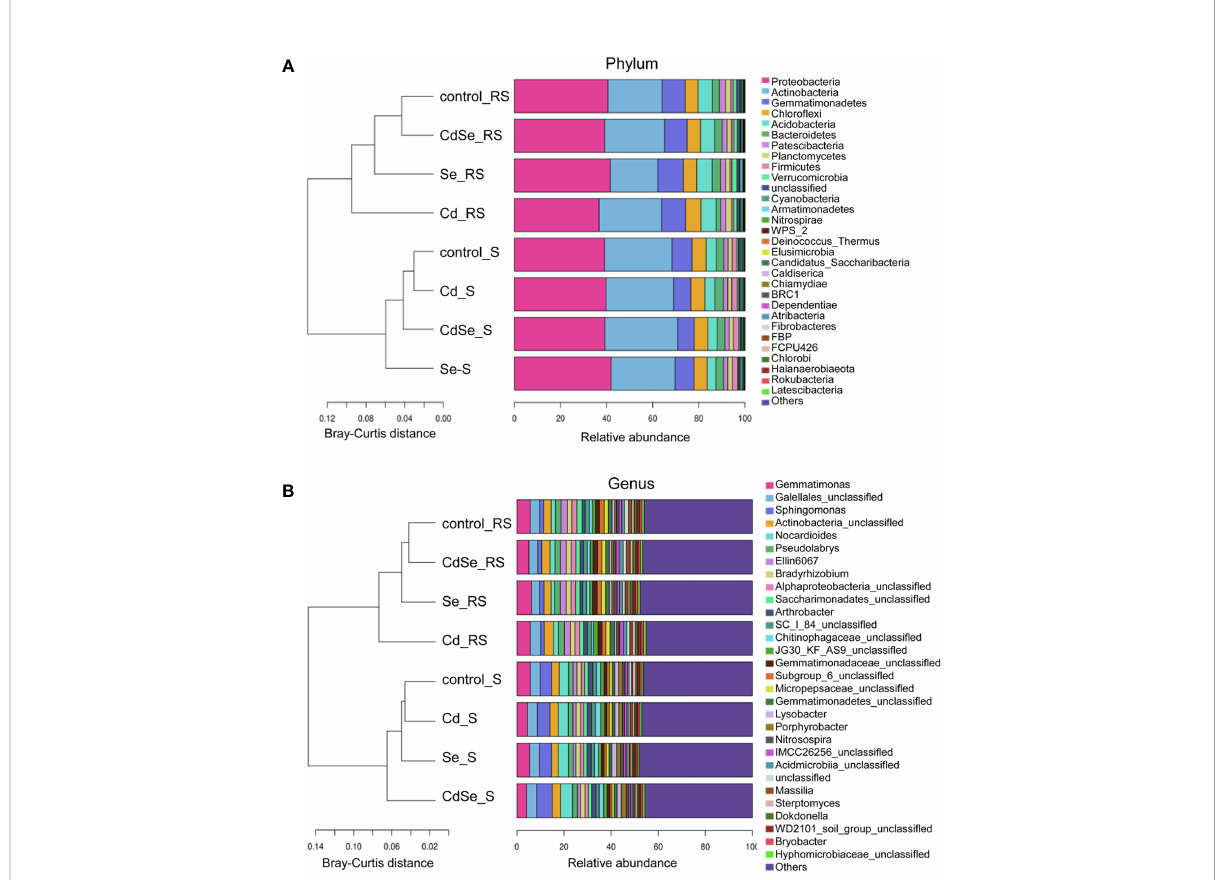
FIGURE 7 Effects of root exposure to Se (1.2 mg/kg) on soil species abundance in perilla under Cd stress (10 mg/kg). (A) Phylum level; (B) Genus